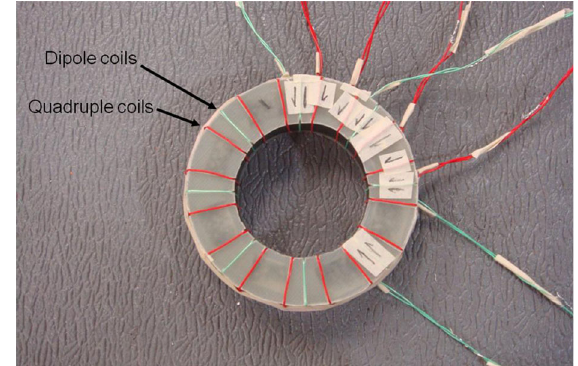
FIG. 7. A combiner prototype with four pairs of dipole coil windings, and four sets of quadrupole coil